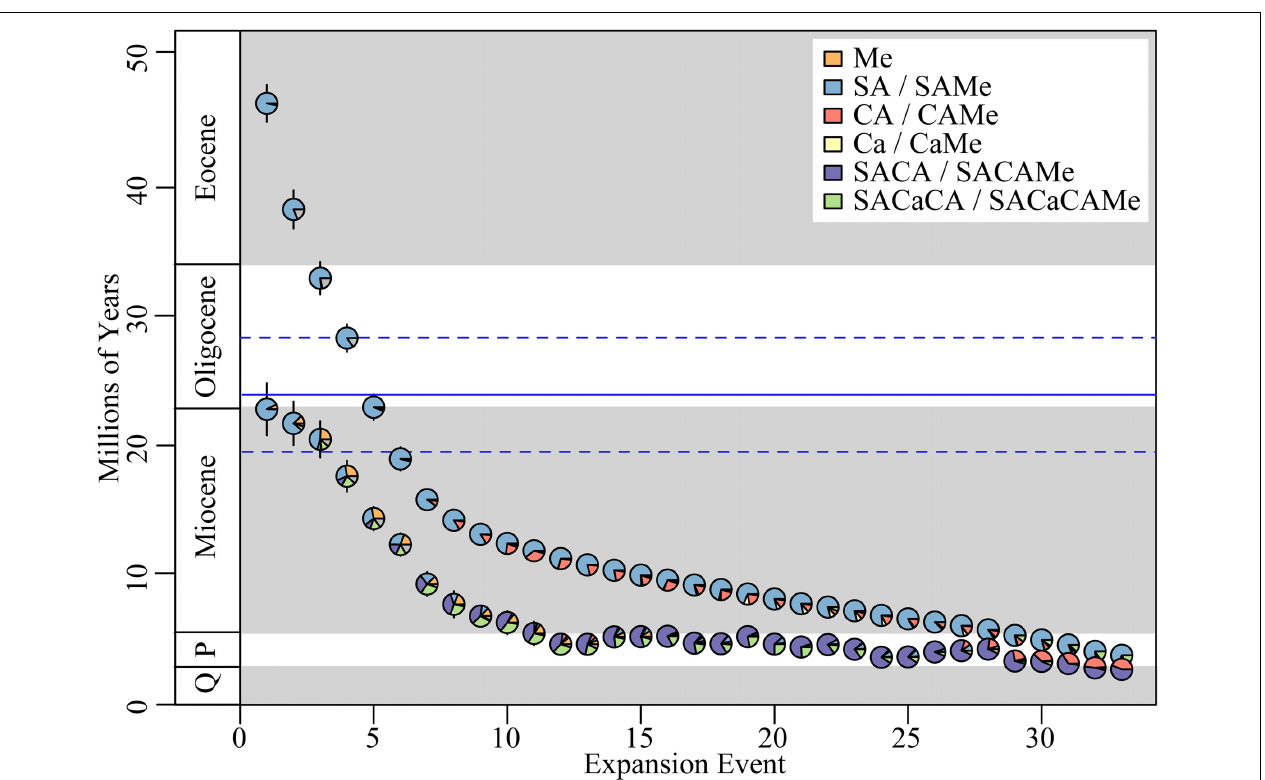
FIGURE 3 | Biogeographic expansions into Mexico. Mean date of each expansion event estimated from Lagrange for both stem, parent nodes (upper row) and crown, daughter nodes (lower row). Error bars represent 95% confidence intervals estimated across mean ages from 100 ML trees. Plot ordered by age of stem node from oldest to youngest. Pie-charts represent the estimated proportion of the ancestral range at each respective node. Parent node range represents the original range, prior to dispersal into